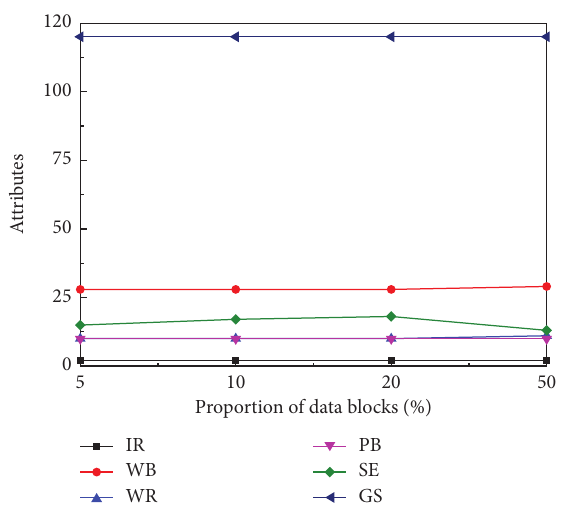
Figure 2: Feature reduction of